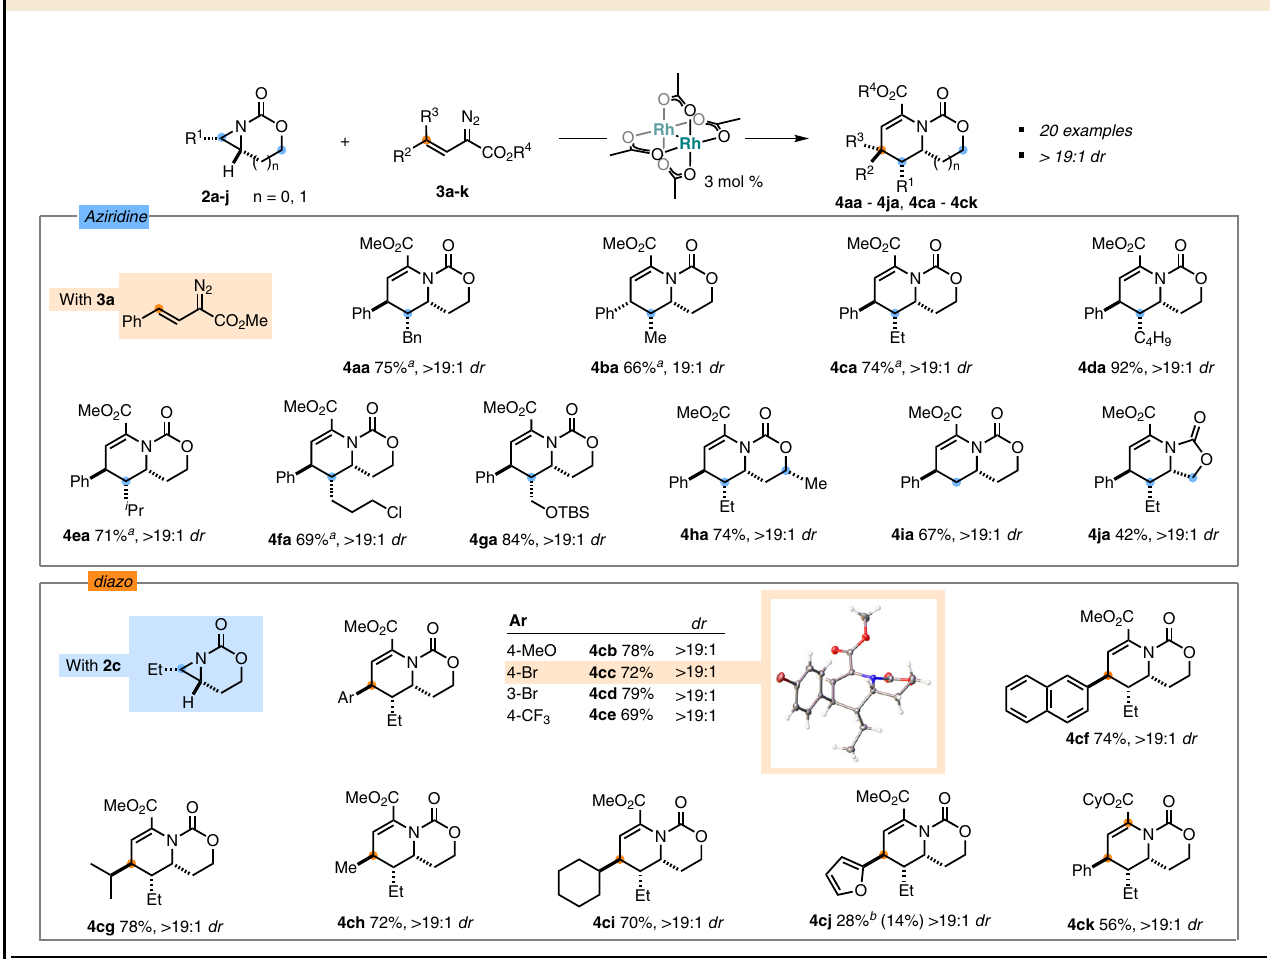
Table 1 Scope of the aziridine and diazoester in Rh-catalyzed ring expansions to